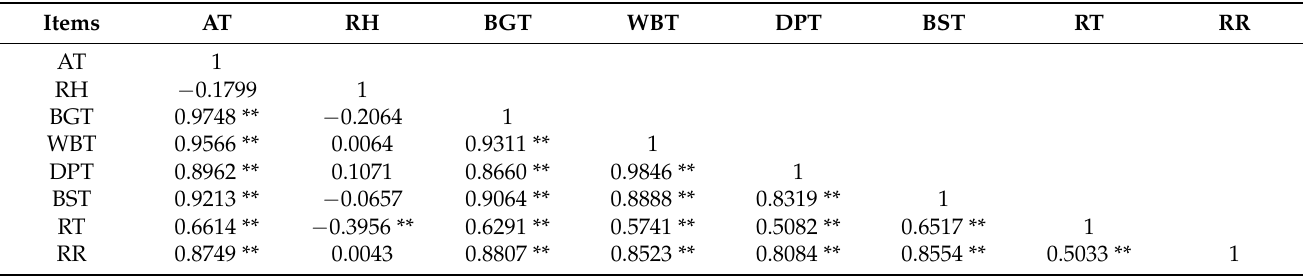
Table 3. Pearson’s correlation analysis of environmental and physiological indices of lactating buffaloes. Items